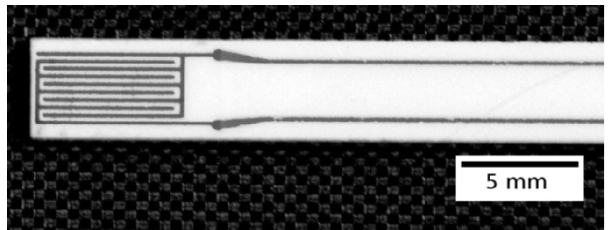
Figure 1. Image of an uncoated blank sensor with interdigital electrodes (IDEs) and feed lines.